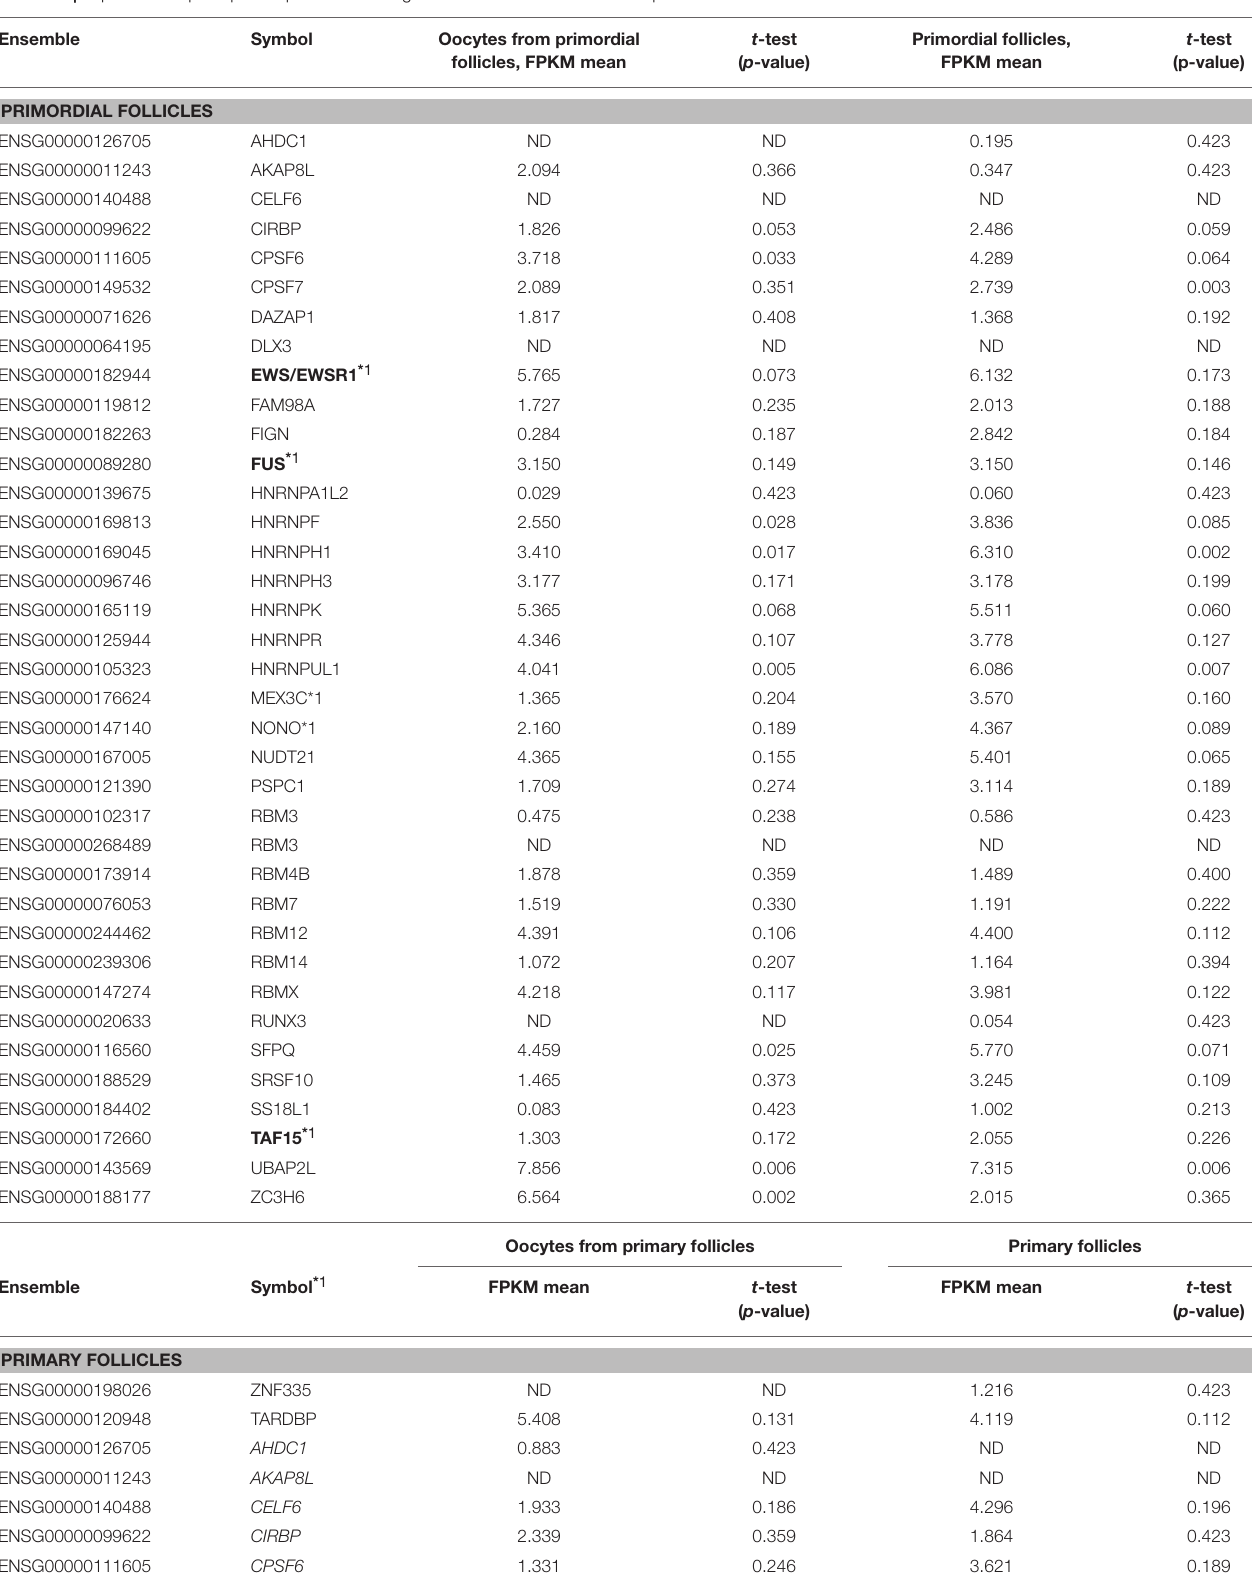
t -test Primordial follicles, ( p -value) FPKM mean